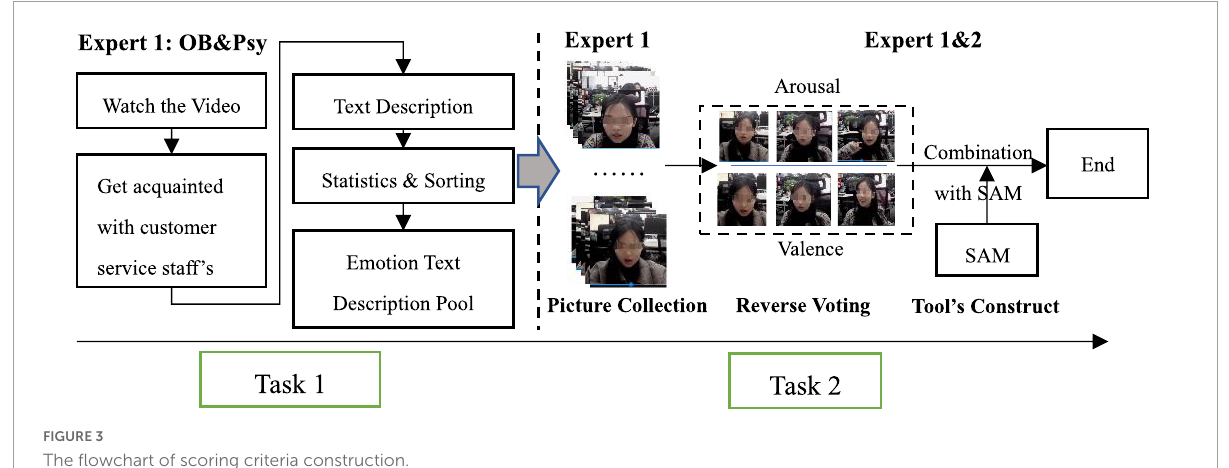
FIGURE3 The flowchart of scoring criteria